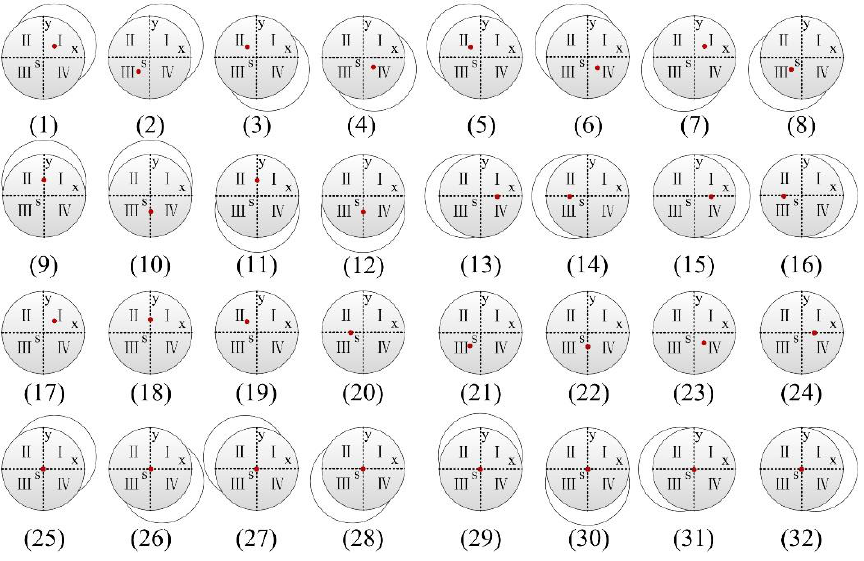
Figure 8. Top view of the SBM deviation.